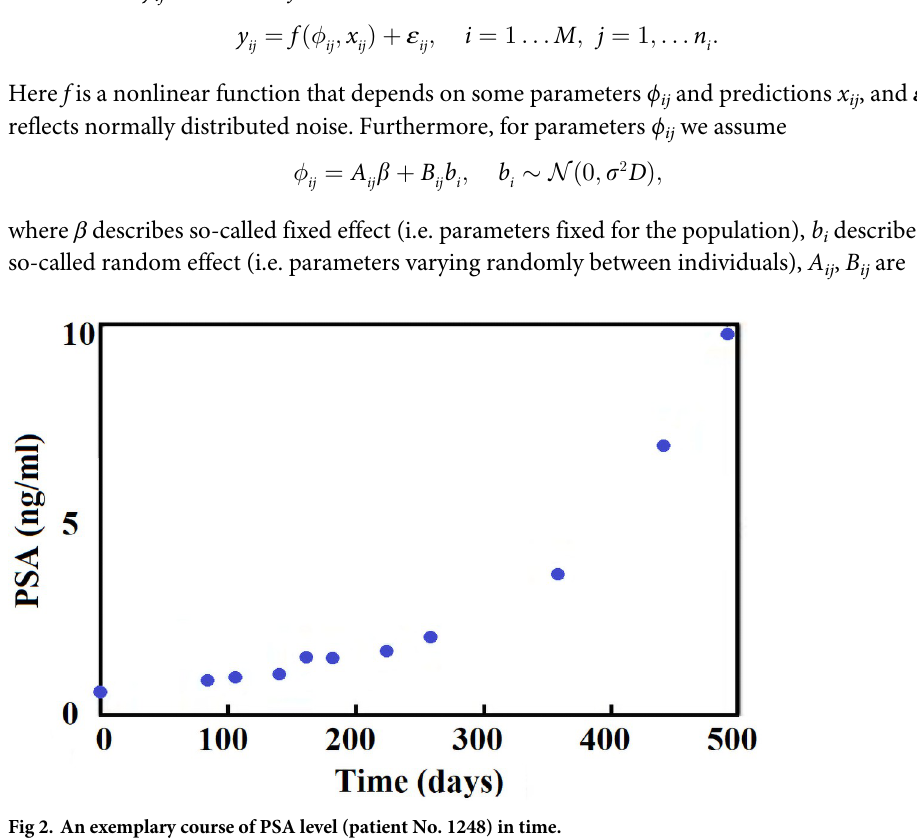
Fig 2. An exemplary course of PSA level (patient No. 1248) in time.